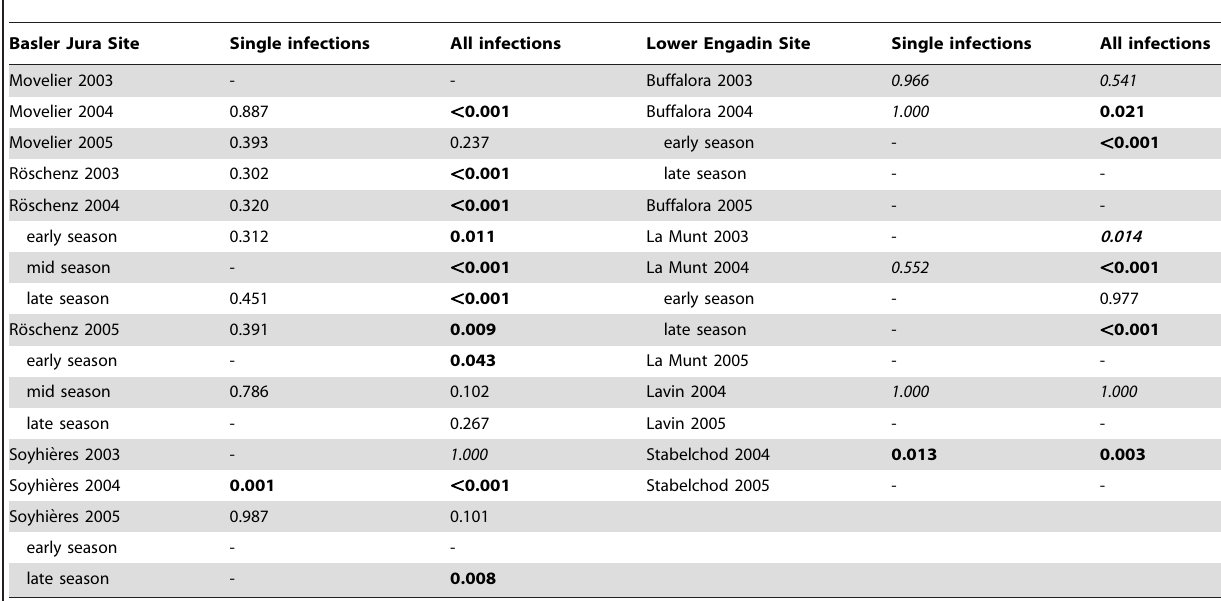
Table 2. P -values (S.E.) for the exact Hardy-Weinberg probability test (score U-test, for Markov chains with 1’000 iterations per batch, 100 batches) for each site and year, including separate sampling